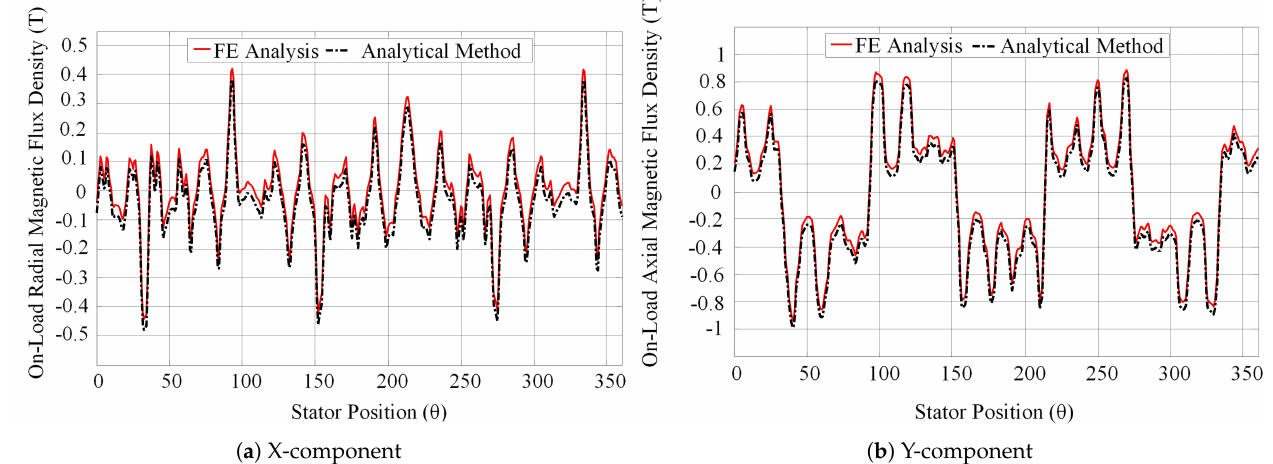
Figure 16. On-Load Comparison of load flux density at y = g/2 (Airgap).